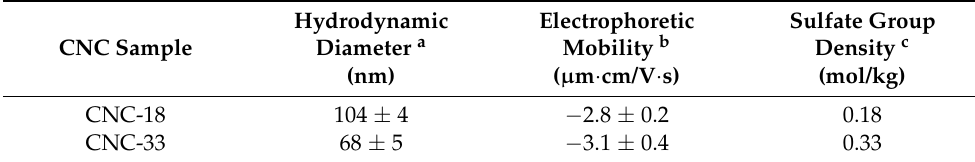
Table 2. Characteristics of the cellulose nanocrystal (CNC) samples. Hydrodynamic CNC Sample Diameter